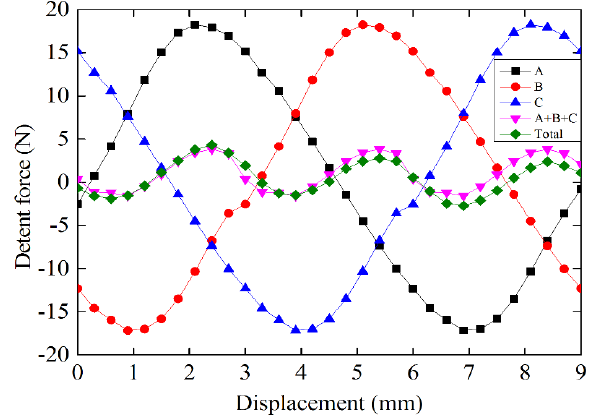
Figure 7. Detent force of STTF ‐ PMLSM.